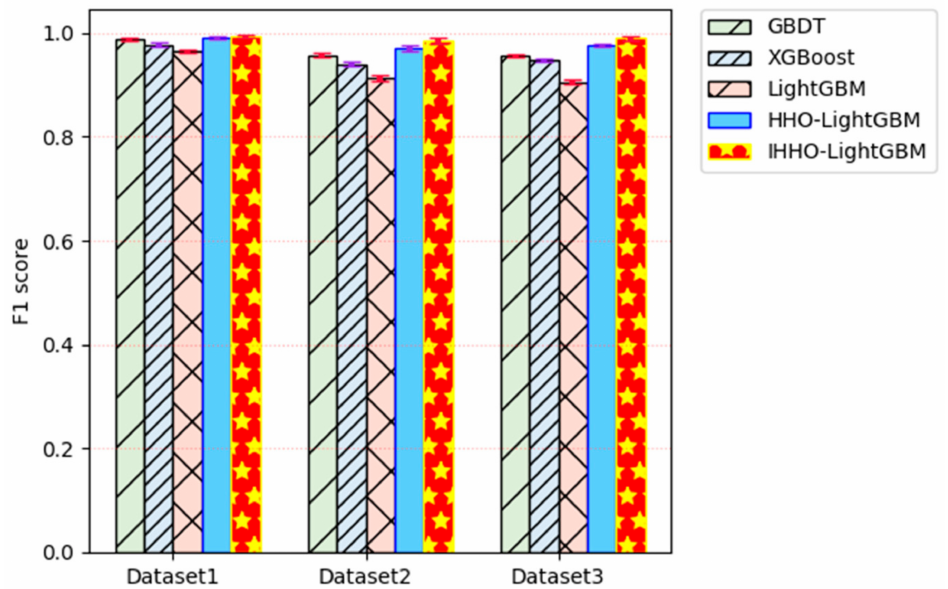
Figure 8. F1-score of four algorithms for fault